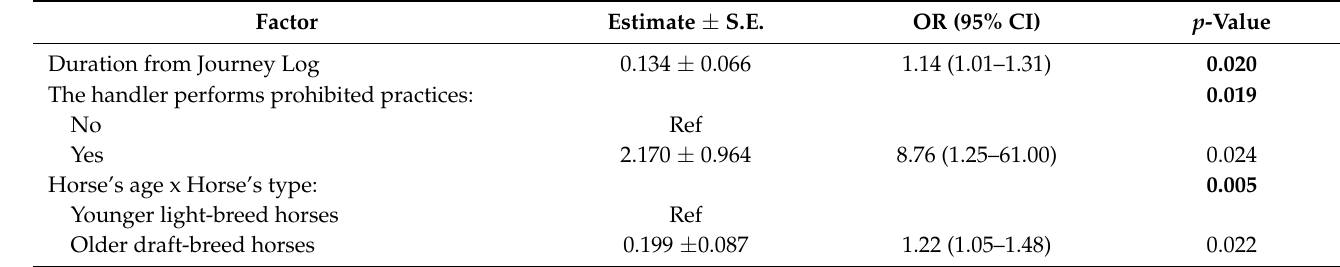
Table 13. Injured tails—final multiple regression model for the dummy dependent variable of presence/absence of injured tails in horses at arrival at the slaughterhouse. Data are presented as estimates and standard errors (S.E.) of the effect, odds ratio (OR), confidence interval (95% CI), and p -value. Bold p -values refer to the statistical significance of the predictive variable in the model; the significance of a category against the reference is reported in regular